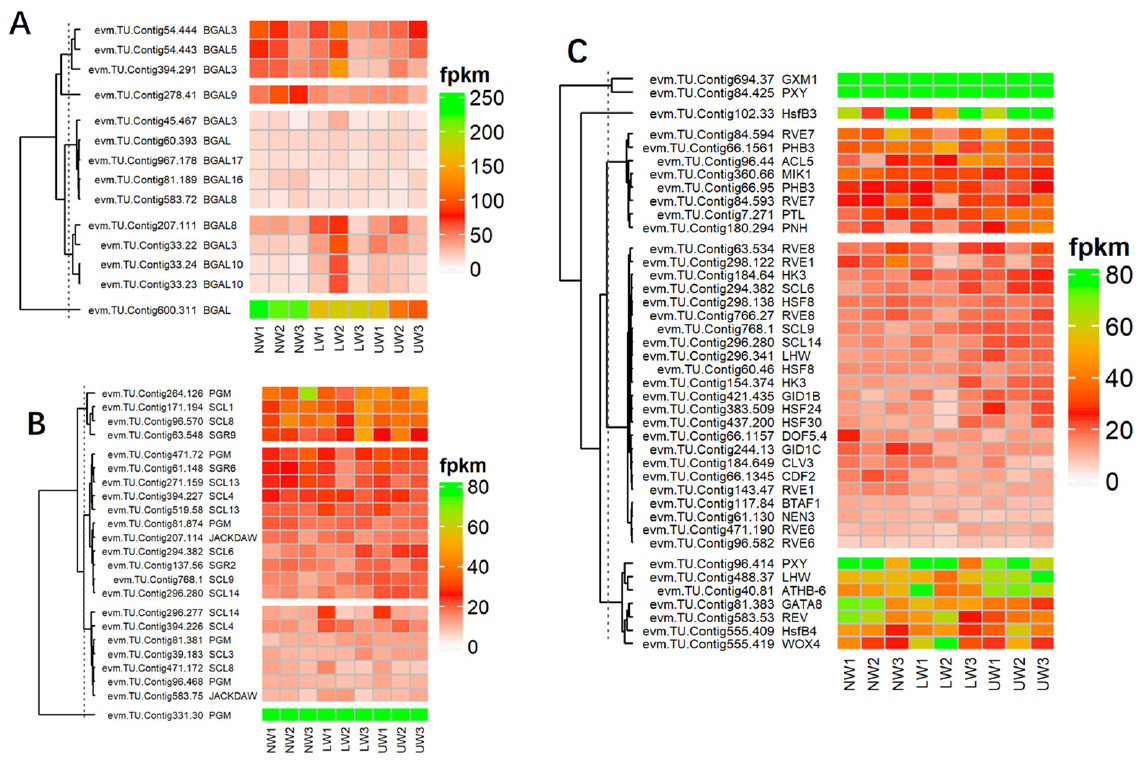
(Table S5). Similarly, many members of β -glucosidase ( BGLU ) genes and cellulose catabolism genes ( CELs ) were differentially expressed in UW and NW samples. The expression of BGLU24 , BGLU13 and BGLU24 was upregulated in UW samples, while CEL1 , CEL3 and CEL5 were significantly downregulated. In contrast, BGAL genes were highly expressed in NW compared to LW and UW. BGAL5 and BGAL3 were highly expressed in NW, while their expression was gradually decreased in LW and UW (Figure 4A).